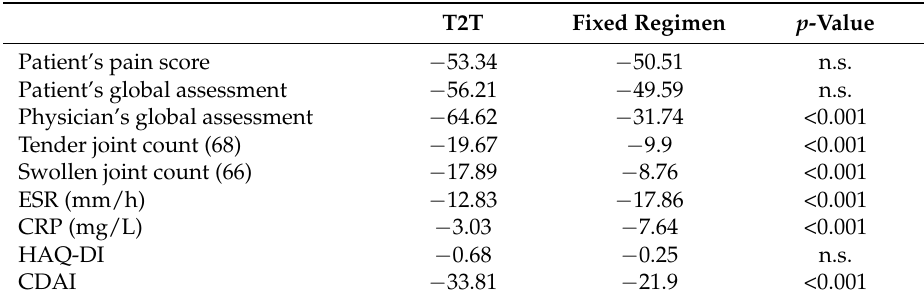
Table 2. Improvement of ACR core components at week 24. T2T Fixed Regimen p